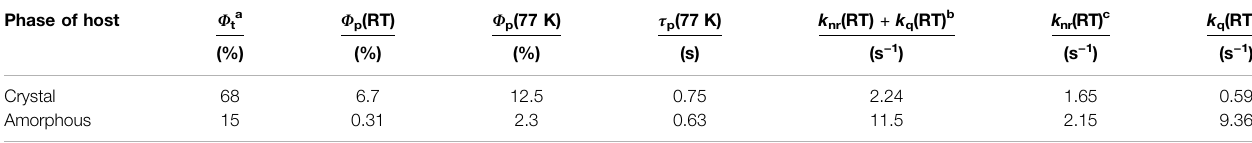
TABLE 1 | Photophysical values relating to phosphorescence of 5 wt% ( S )-BINAP-doped ( S )-H 8 -BINAP solids in crystalline and amorphous states. Phase of host Φ ta